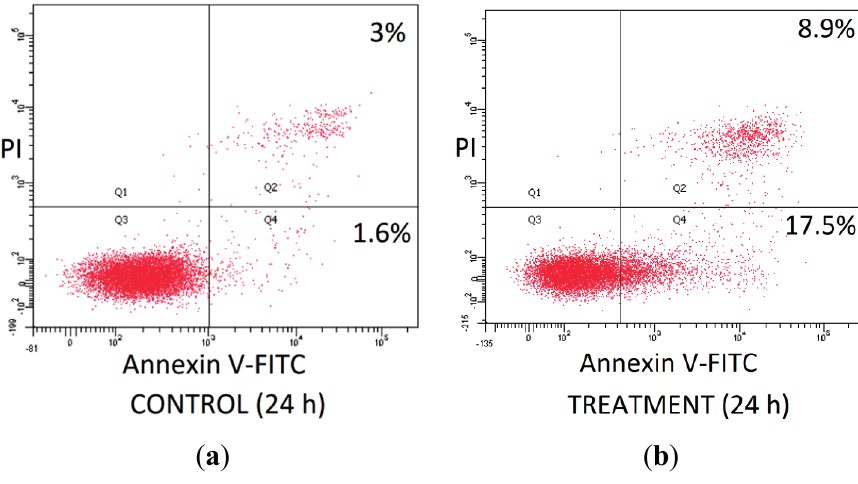
Figure 4. Detection of apoptosis using flow cytometry after annexin V-FITC/propidium iodide (PI) staining for ( a ) Control and ( b ) Treatment. Viable cells are in the lower left quadrant (Q3); early apoptotic cells are in the lower right quadrant (Q4); late apoptotic cells are in the upper right quadrant; and non-viable necrotic cells are in the upper left quadrant (Q1).